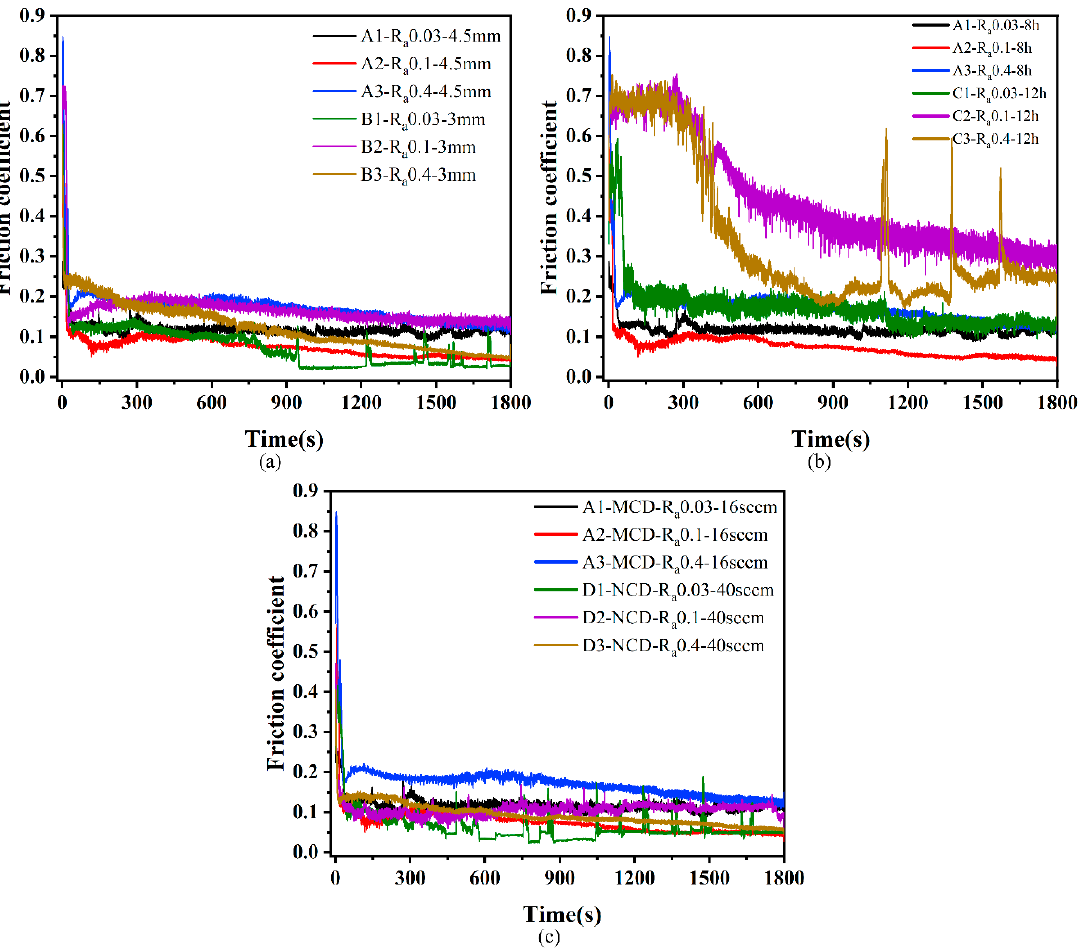
Figure 10. Friction coefficient curves of diamond films with substrates of different roughnesses under 20 N load: ( a ) friction coefficient curves of diamond films at different deposition distances; ( b ) friction coefficient curves of diamond films at different deposition times; ( c ) friction coefficient curves of MCD and NCD.